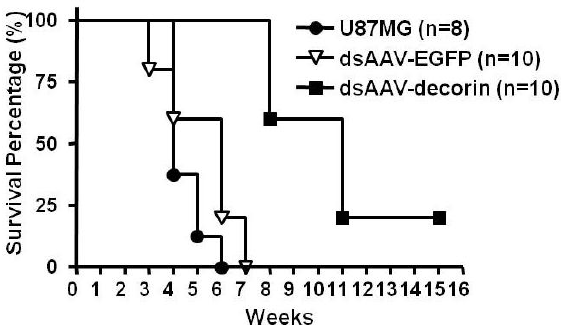
Figure 2. Gene delivery of dsAAV-decorin prolonged the survival of nude mice that bear malignant U87MG gliomas in the brain. U87MG cells (5 × 10 5 /mouse) were stereotactically injected (i.c.) into the brain of nude mice. Five days post-implantation, dsAAV-decorin vectors were delivered at MOI = 10,000 via intraturmal injection through the same barrel hole in the skull where the tumor cells were injected. No mice died